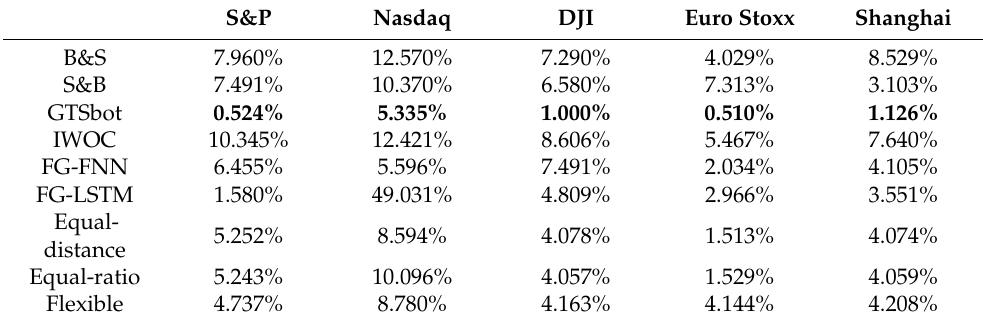
Table 17. Comparison of